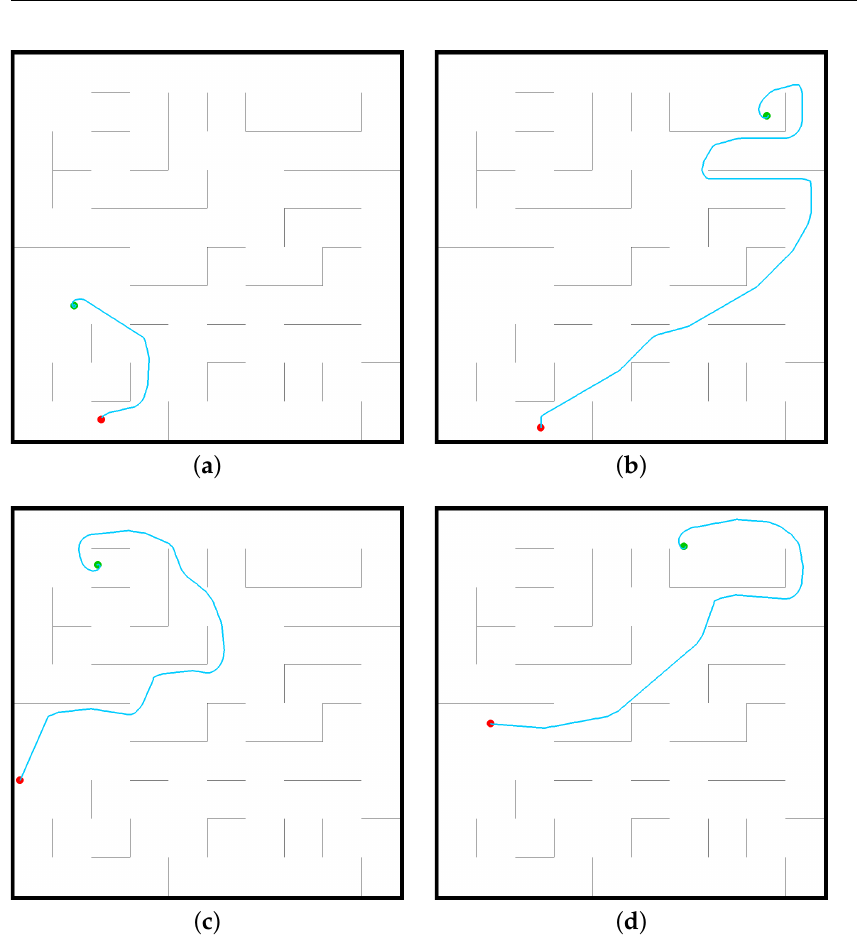
Figure 8. Successful cases using a DL algorithm to solve the mobile robot navigation task through analysis in RoNAP: ( a ) DL_case1, ( b ) DL_case2, ( c ) DL_case3, ( d )